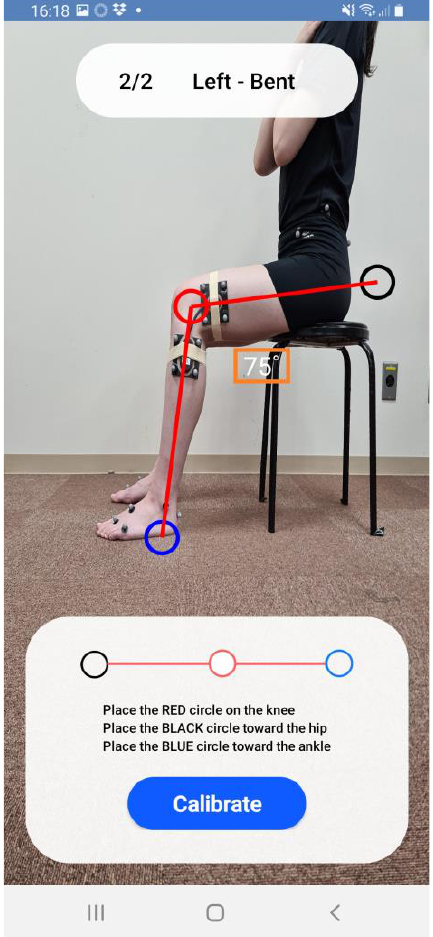
Figure 2. Photograph calibration of the wearable goniometer in the sitting position.